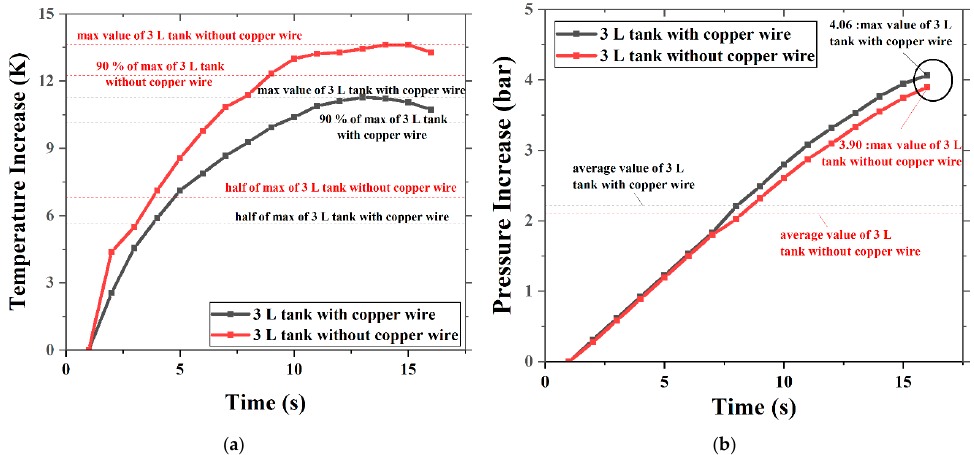
Figure 4. Experimental response of 3 L gas tank: ( a ) temperature response and ( b ) pressure response.